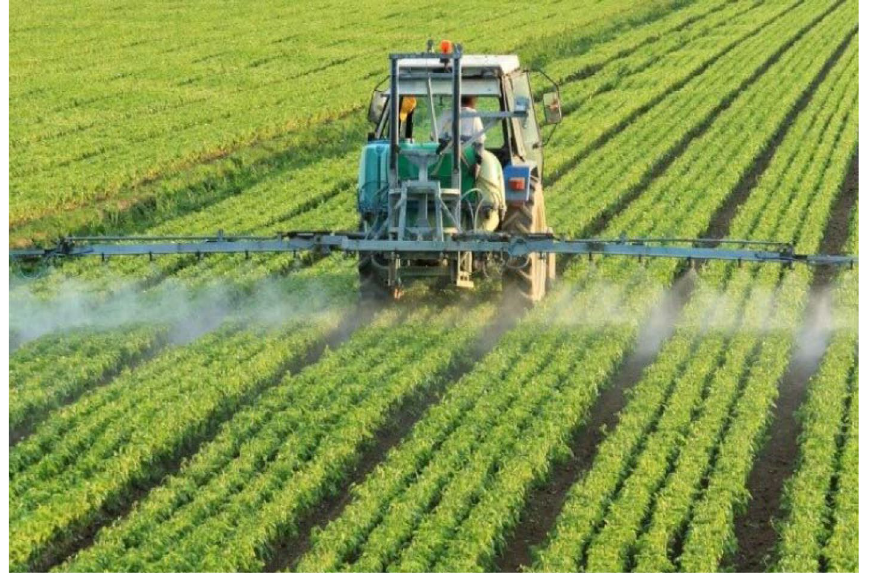
Figure 1. Agri-food production 10